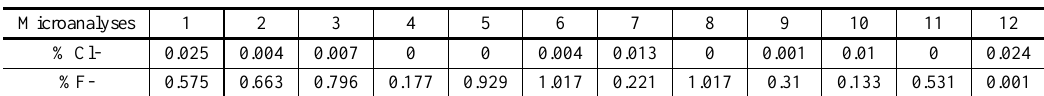
Fluorine and chlorine microprobe analysis in phengitic white mica. Fluorine is present in amounts up to ∼ 1% , yet the concentrations of chlorine are below the detection limit of this method, indicating an absence of